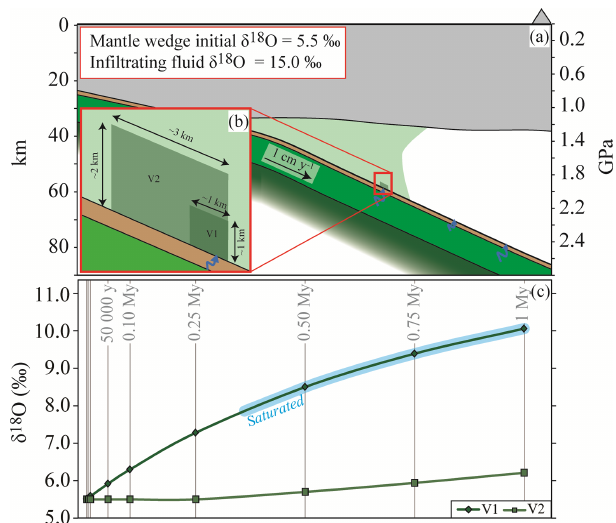
Figure 9. Case model for mantle wedge hydration. (a) Sketch of a subduction zone (crustal thickness and serpentinized mantle wedge dimensions are from Bostock et al., 2002). The subducting slab is composed of metabasalt ( a ) and metasediment ( t ) as shown in Fig. 1a, left column. (b) Geometry of the model. The blue arrow represents slab dehydration at 500–520 ◦ C. Abbreviations: V1 represents the volume of mantle rocks at the interface and V2 the surrounding vol- ume (see text for details). (c) Plot of the bulk δ 18 O variations of V1 and V2 as a consequence of continuous slab dehydration over